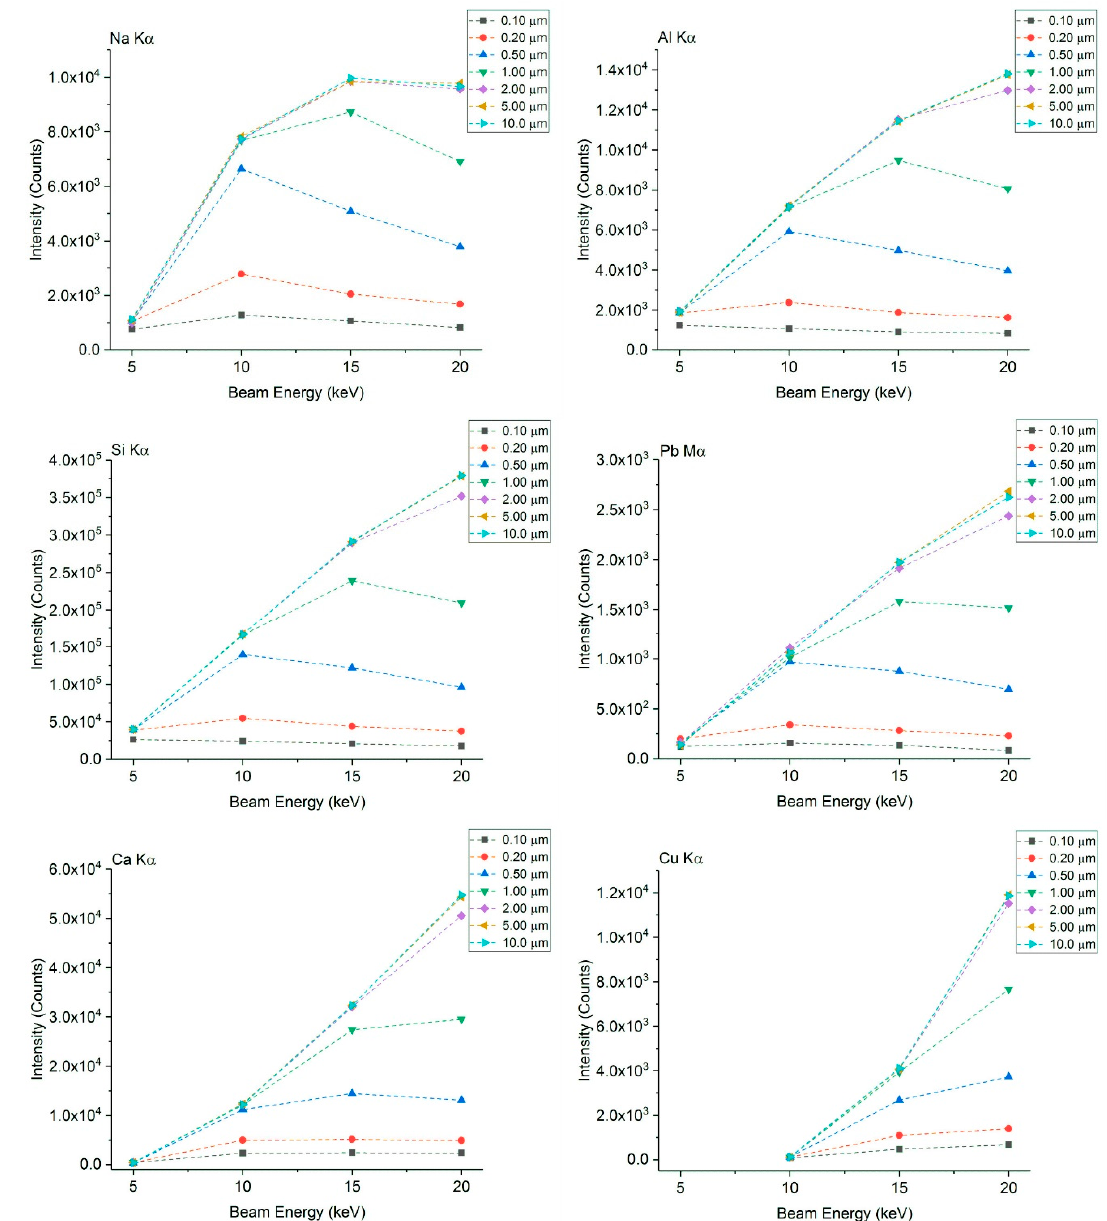
Figure 4. Simulation of the SEM-EDS X-ray intensity of the sodium, aluminum, silicon, calcium, copper K α lines and lead M α line as a function of both the electron beam energy and thickness of the prismatic shaped sample fragment (according to the scheme of Figure 2). The statistical variation for each point is of the order of 1%.